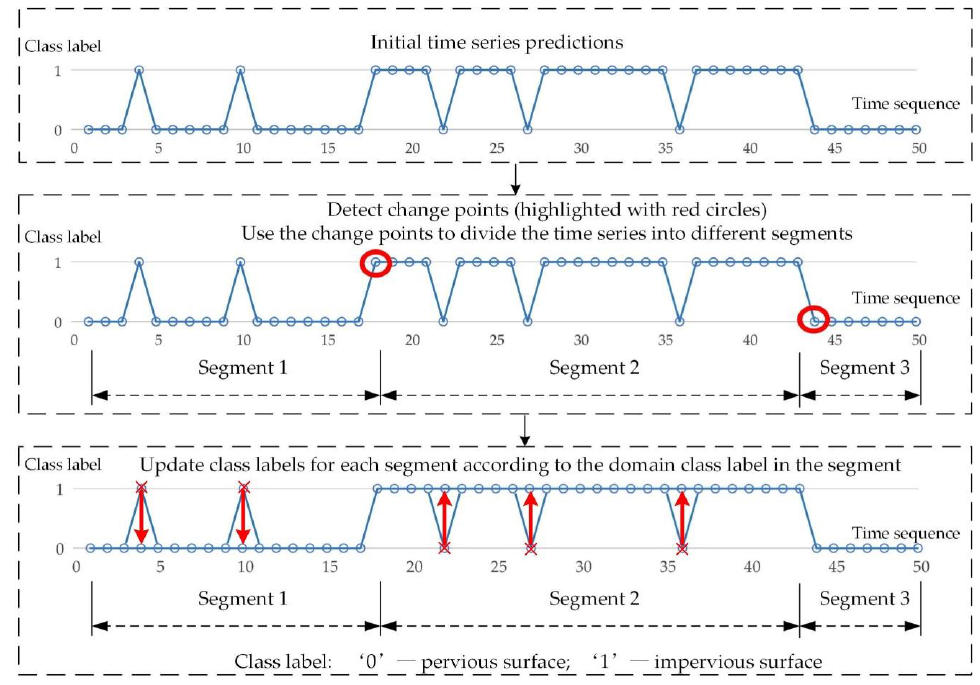
Figure 5. Schematic diagram of a temporal consistency check model.